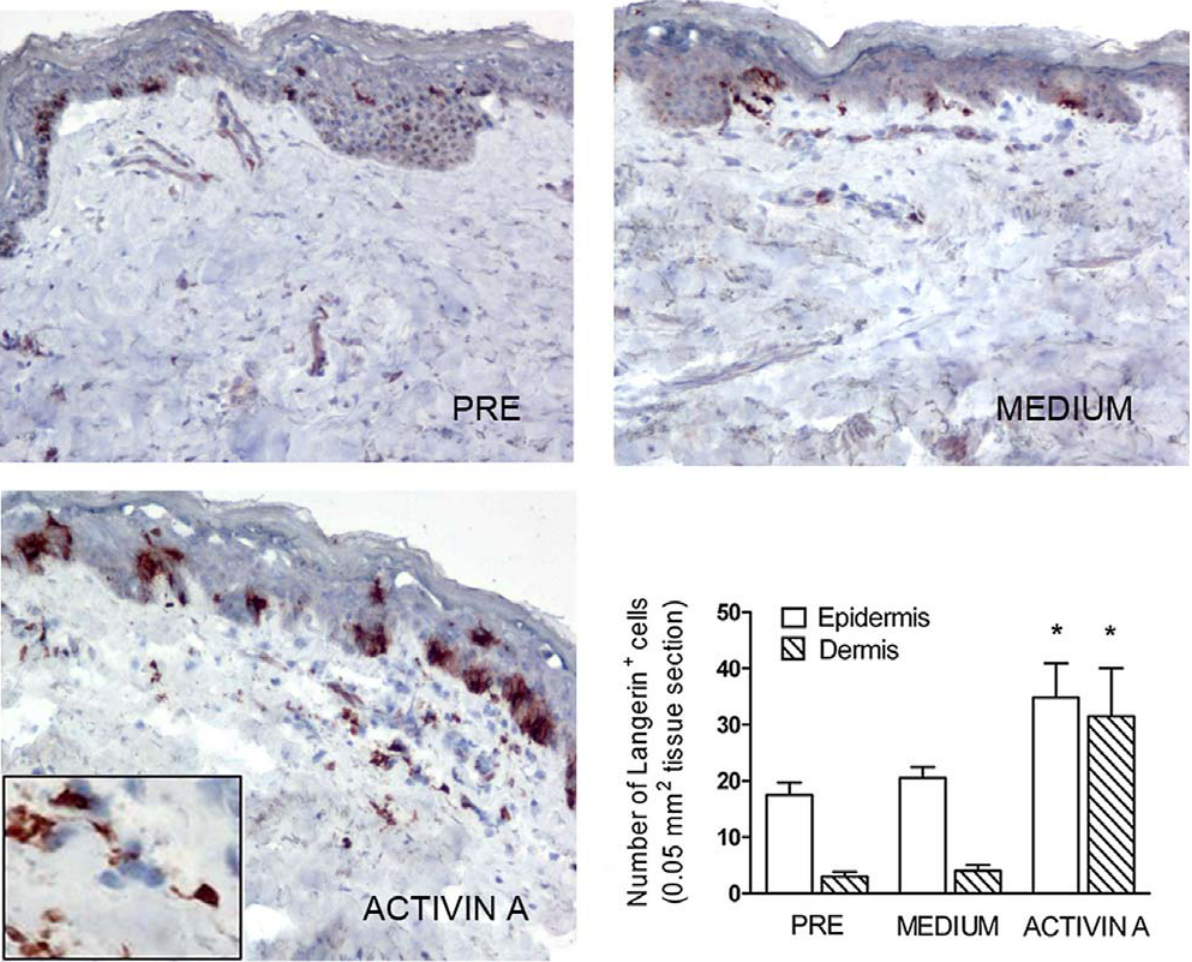
Figure 3. Intradermal injection of Activin A induces the differentiation of dermal and epidermal Langerhans cells in human skin explants. Langerin expression was evaluated in the epidermis and dermis (full thickness skin explants) of skin explants, untreated and 72 hrs after i.d. injection of medium or 100 ng Activin A (magnification 100X, inset 400X) The number of Langerin + cells were quantified in skin explants by evaluating six different skin sections (0.05 mm 2 /field; means 6 SD). * p , 0.05 by Student’s t test vs. medium (lower right panel).